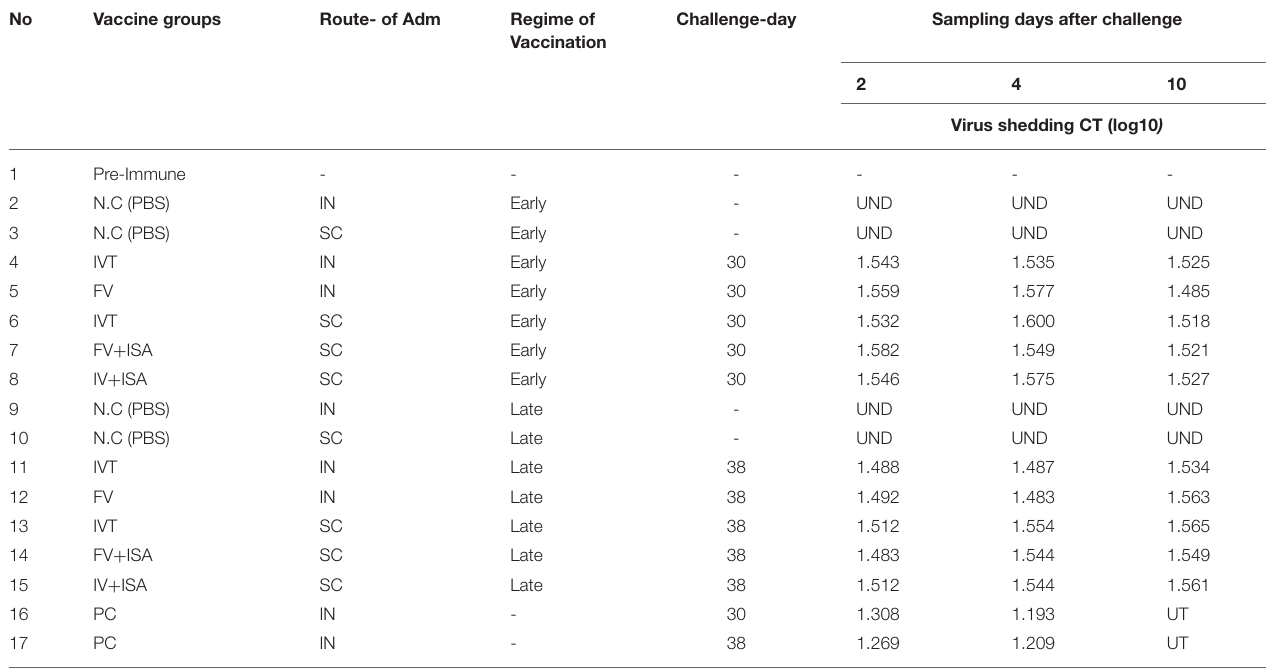
UND, Undetermined; UT, Un-tested.